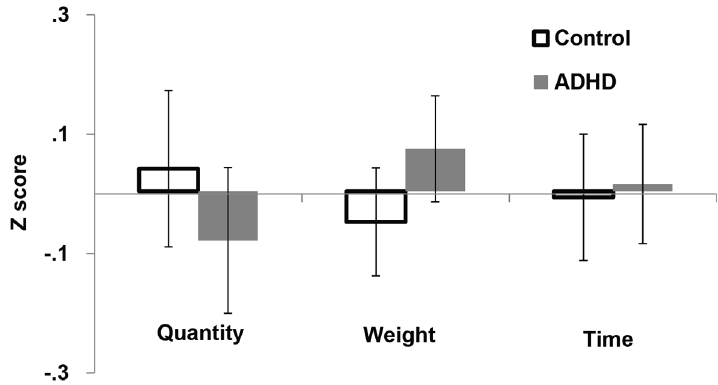
Figure 5. Mean estimations in different categories as a function of group. Note. The results indicated that ADHD participants had comparable cognitive estimation abilities in all the estimation